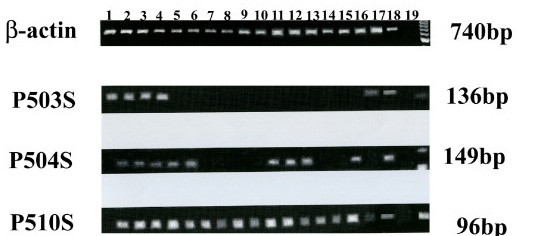
Analysis of gene expression levels of p503S, p504S and p510S by RT-PCR using β-actin yielded a 740 base-pair band as internal control in whole blood from 17 of 20 patients with benign prostatic disease (BPH).